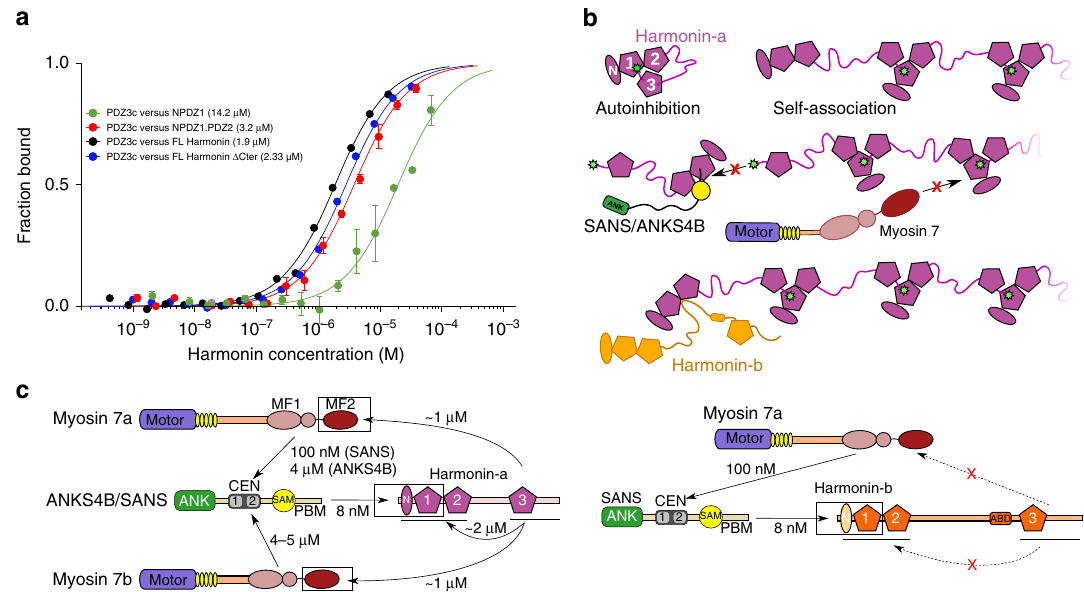
Figure 5 | Intramolecular interaction between the N- and C-terminus of harmonin and compatibility with Myo7 clustering. ( a ) Representative MST binding curves measuring the interactions between PDZ3c and NPDZ1, NPDZ1.PDZ2, FL-harmonin D Cter or FL-harmonin. The deduced K d is indicated in parentheses. Averaged K d s from two technical replicates (mean ± s.d.) are shown. ( b ) Proposed models of harmonin interactions. Top: Harmonin can